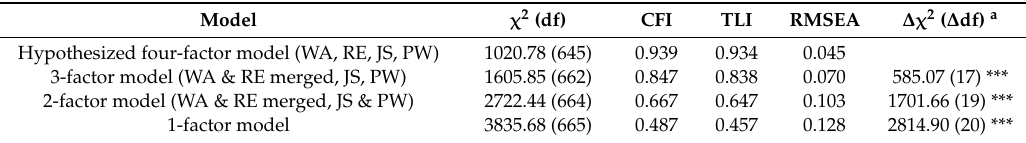
Table 2. Model fit statistics for measurement